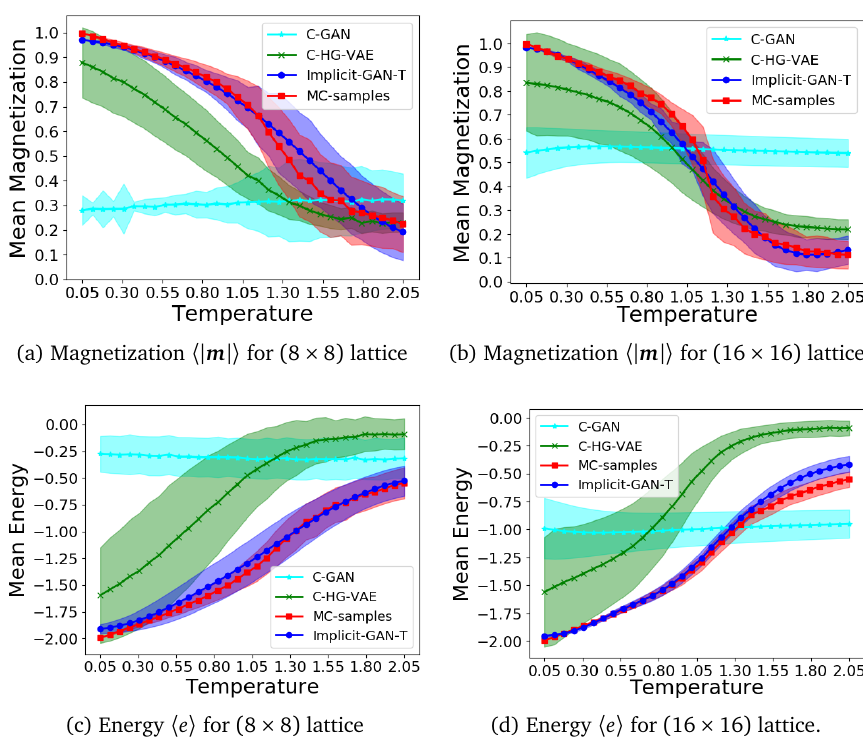
Figure 2: Expectation values (dots and lines) of observables (normalized per site) computed from samples generated by the indicated methods as a function of tem- perature. Shaded portions represent the standard deviation of the corresponding observable. MC samples are taken as the ground truth; the method giving more overlap with the ground truth is